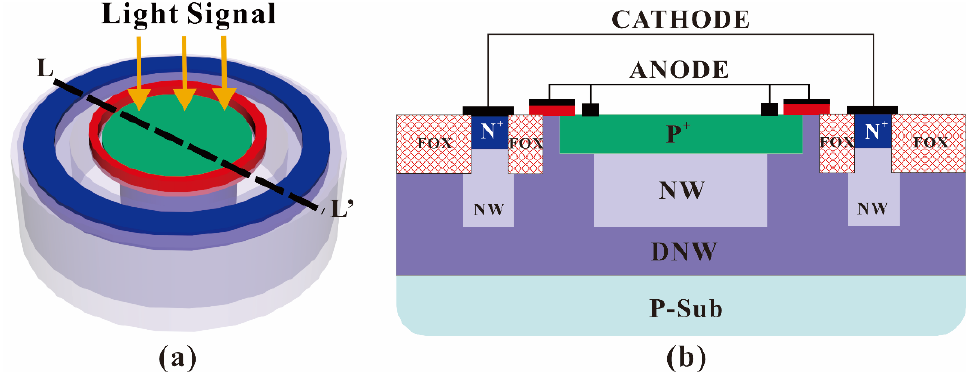
Figure 1. Three-dimensional schematic structure of HDEPD device ( a ) and cross-section of HDEPD device ( b ) .